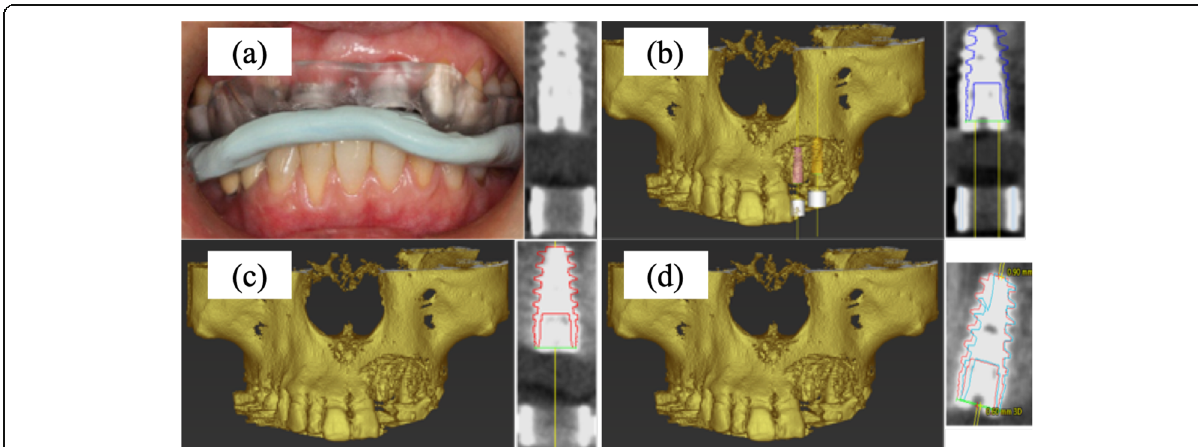
Fig. 1 Evaluation method of implant validation. a Immediately after the implant installation, the surgical guide used for the surgery was attached, and a cone-beam computed tomography scan was performed with the bite index prepared in advance to stabilize the position. b The position of the planned implant body was specified from the position of the metal sleeve in the jaw bone model, and implant model 1 was installed there. c Implant model 2 was placed according to the implant body actually inserted. d The deviation between the implant models was measured three-dimensionally on the jaw bone model